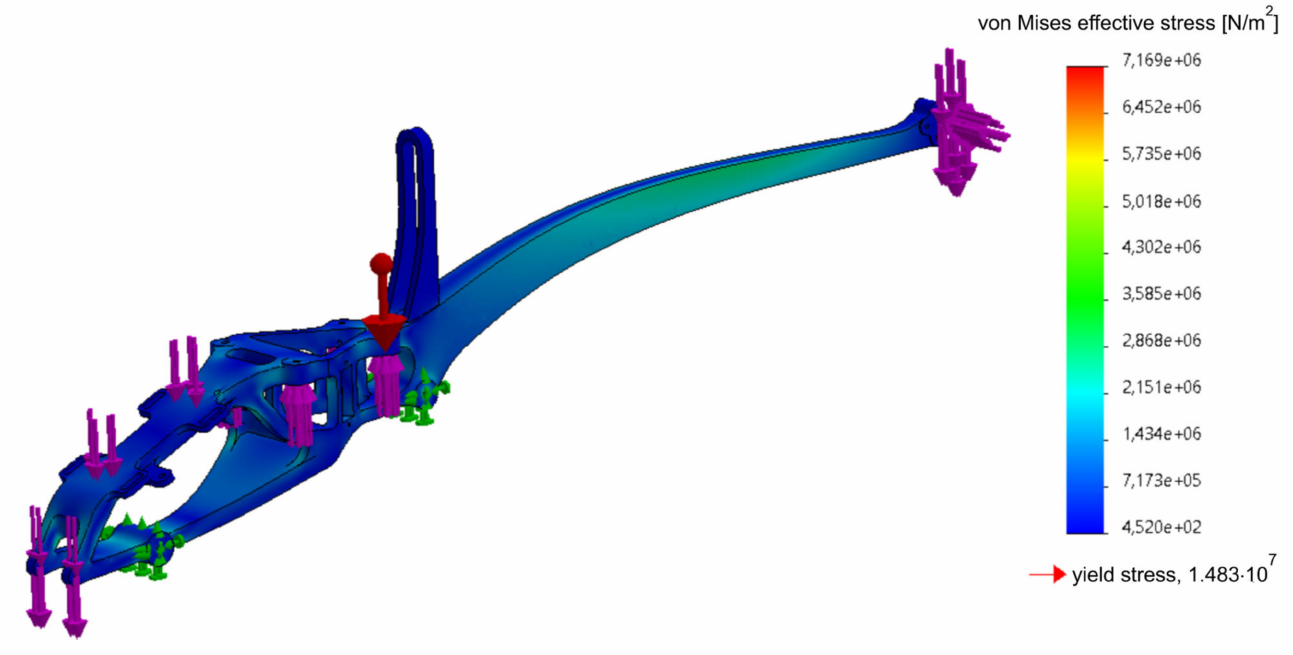
Figure 17. Static analysis of the primary part of the frame (frame weight 180.14 g).